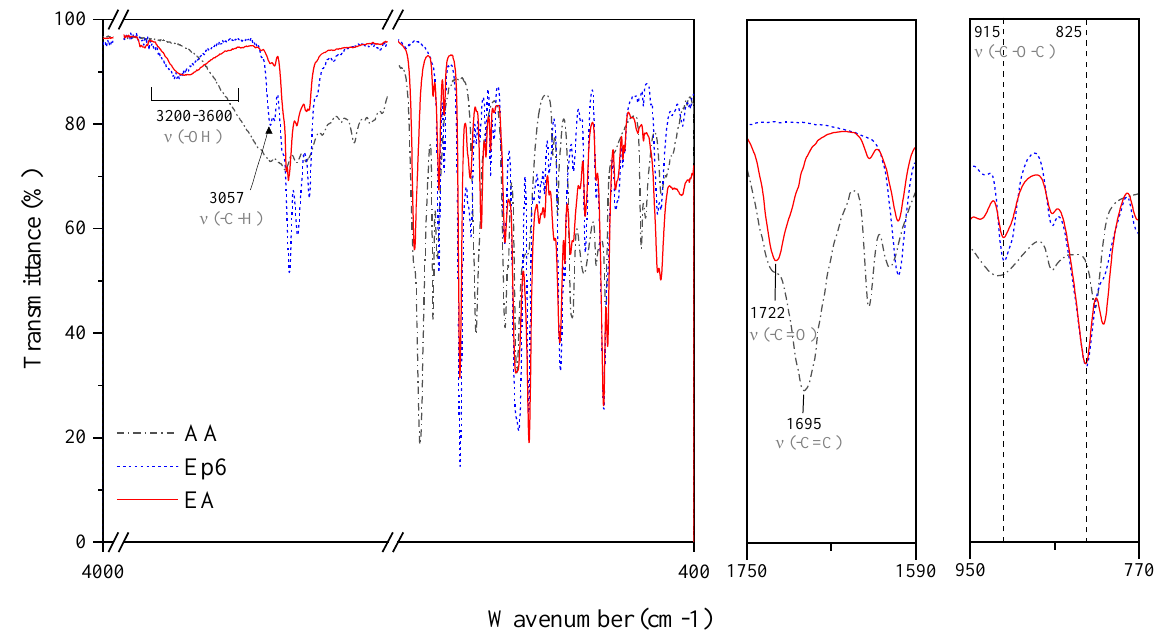
Figure 7. FT-IR spectra of epoxy resin, methacrylic acid, and EA prepolymer. The product of reaction was also characterized for the non-volatile-matter content (NV), partial acid value (PAVs), and epoxy equivalent (EE). Each of these can be regarded as a measure of reaction progress, which was referred to as the % of reacted epoxide groups as well as % of reacted AA and expressed as epoxy group conversion (EGC) and acrylic acid conversion (AAC). The synthesized EA prepolymer was 98.4% solids (NV). The viscosity of the resin increased and is 70 Pas. The acid number of the product (PAVs) was 2.9 mgKOH/g, which indicates a conversion of acrylic acid in the amount of 97.9%. In turn, the EE was 408, so the conversion degree of epoxy groups was 49.6%. The molecular weight of the obtained prepolymers was 977